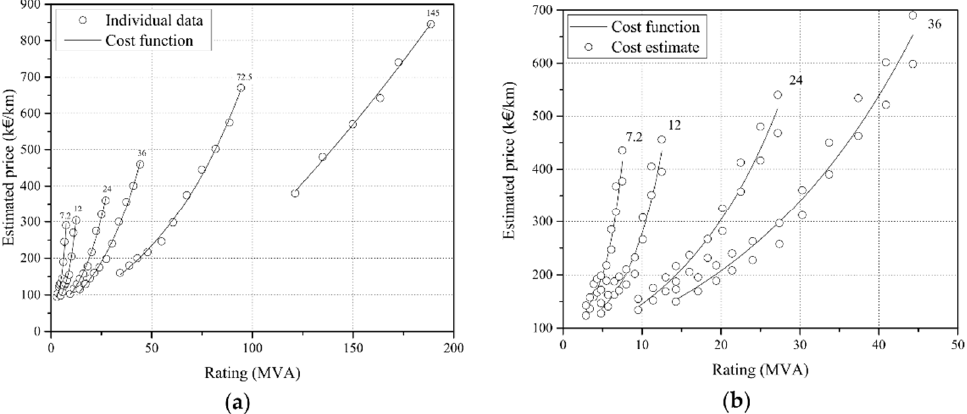
Figure 5. Cost data for offshore cables, where the number above each curve is the rated voltage in kV: ( a ) static offshore cable; ( b ) dynamic offshore cable. Reproduced with permission from [16].